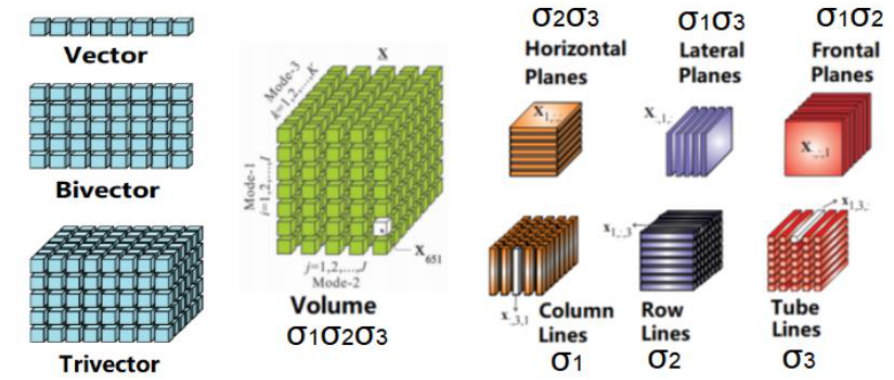
Figure 2. Basic components of 3D magnetic resonance image structure data based on third-order tensor [52].